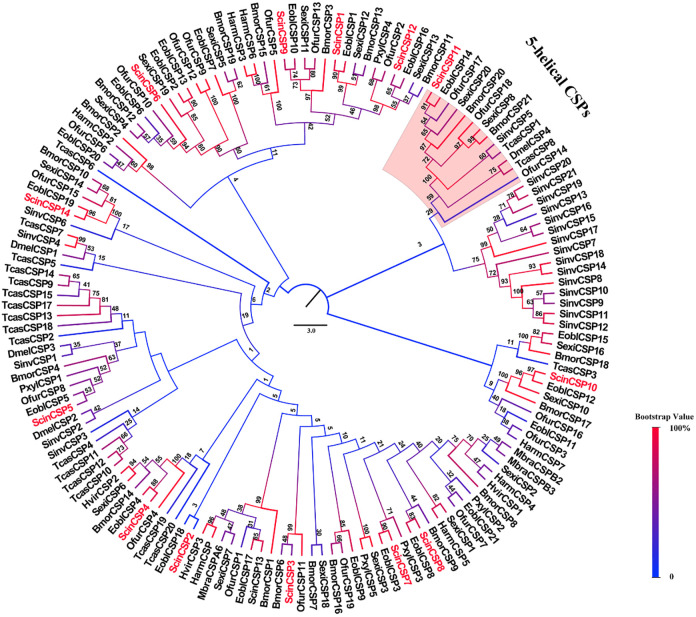
Phylogenetic tree of CSP proteins.Sequences used were from Hymenoptera (Solenopsis invicta), Coleoptera (Tribolium castaneum), Diptera (Drosophila melanogaster), and Lepidoptera (Bombyx mori, Helicoverpa armigera, Heliothis virescens, Mamestra brassicae, Manduca sexta, Plutella xylostella, Ectropis obliqua, Spodoptera exigua, Ostrinia furnacalis). The sequences listed in S5 Table.